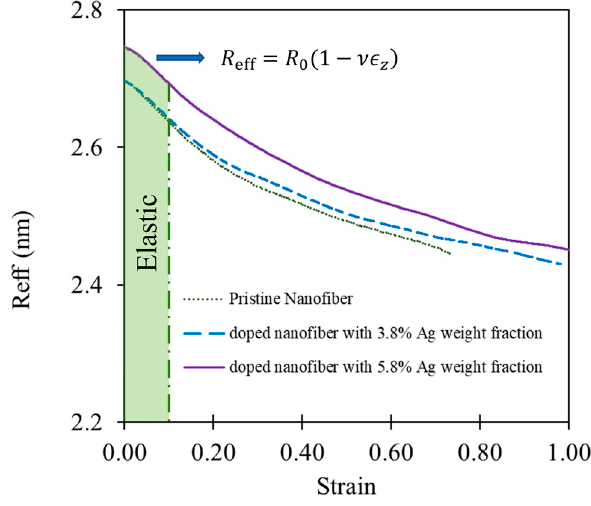
Figure 7. The change in effective radius during deformation and determination of Poisson’s ratio. In addition to the stress curve, the strain energy density (cid:2900)(cid:2925)(cid:2930)(cid:2915)(cid:2924)(cid:2930)(cid:2919)(cid:2911)(cid:2922) (cid:2915)(cid:2924)(cid:2915)(cid:2928)(cid:2917)(cid:2935)(cid:2879)(cid:2919)(cid:2924)(cid:2919)(cid:2930)(cid:2919)(cid:2911)(cid:2922) (cid:2926)(cid:2925)(cid:2930)(cid:2915)(cid:2924)(cid:2930)(cid:2919)(cid:2911)(cid:2922) (cid:2915)(cid:2924)(cid:2915)(cid:2928)(cid:2917)(cid:2935) ( (cid:2924)(cid:2911)(cid:2924)(cid:2925)(cid:2916)(cid:2919)(cid:2912)(cid:2928)(cid:2915) (cid:2932)(cid:2925)(cid:2922)(cid:2931)(cid:2923)(cid:2915)